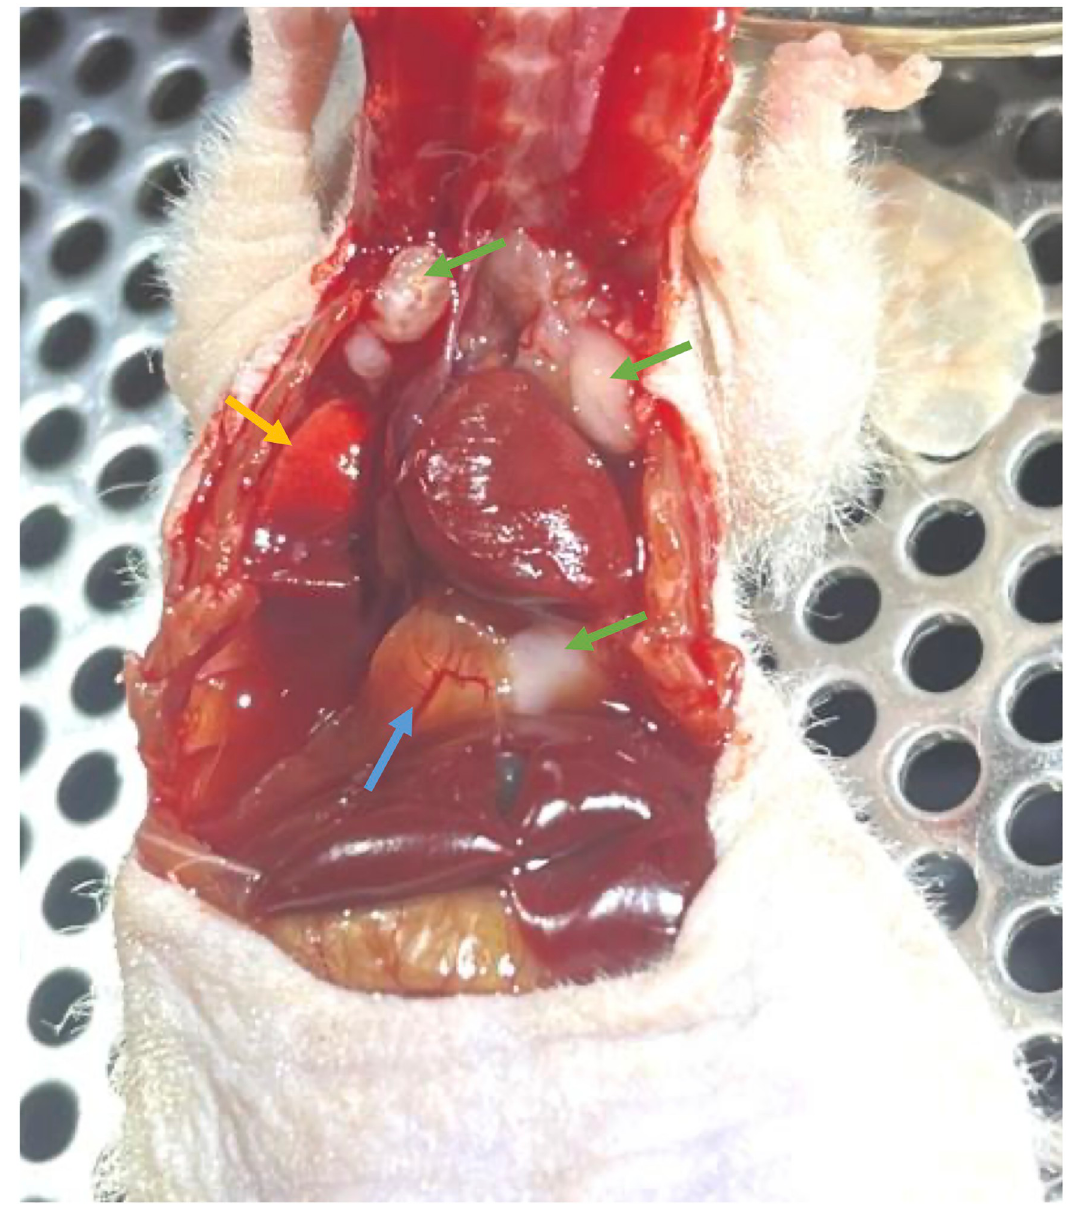
Fig 6. Examples of lung external tumors located in the thoracic cavity. Tumors are indicated with the green arrows while the lung is indicated with the yellow arrow. The blue arrow indicates the diaphragm, on which the lowest of the three indicated lesion sits. This example animal is shown pre-perfusion during necropsy with multiple lung external lesions visible in the thoracic cavity. The mouse was injected with tumor cells into the right lung as per the methodology outlined.